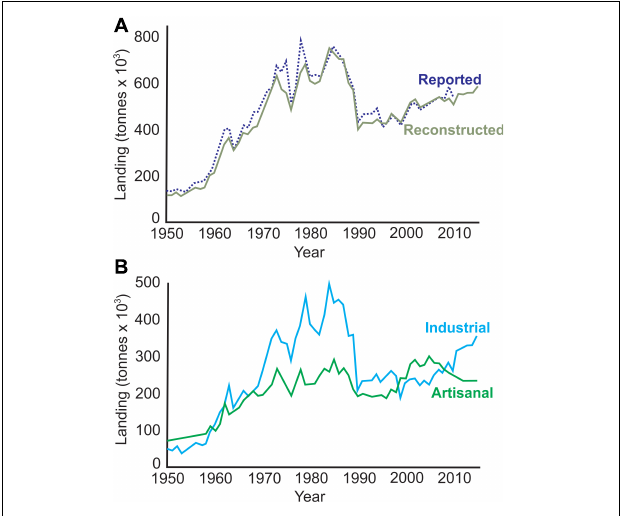
FIGURE 2 | Reported (1950–2011) and reconstructed (1950–2015) landings from Brazilian marine waters (A) and reconstructed landings split into artisanal and industrial fleets for the same period (B) . Reported values refer to data directly obtained from national bulletins.